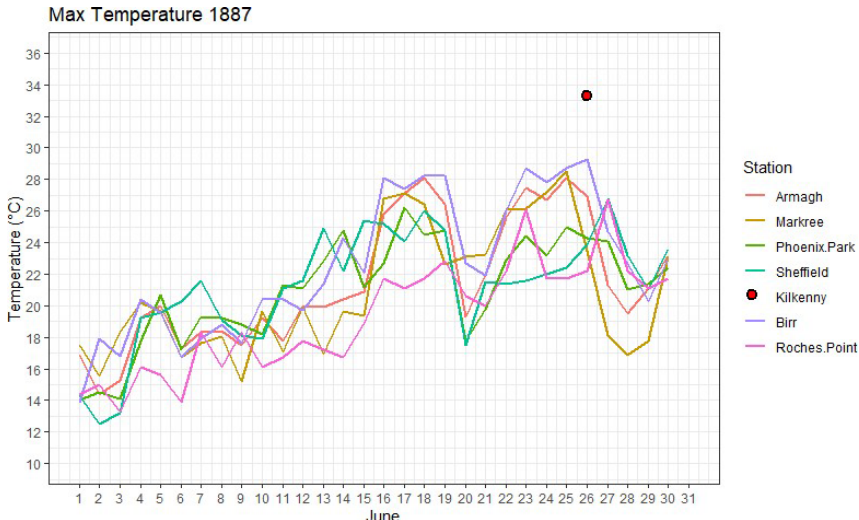
Figure 3. The maximum air surface temperatures of the six selected weather stations for the month of June 1887. The red point marker displays the maximum surface temperature recorded at Kilkenny on 26 June